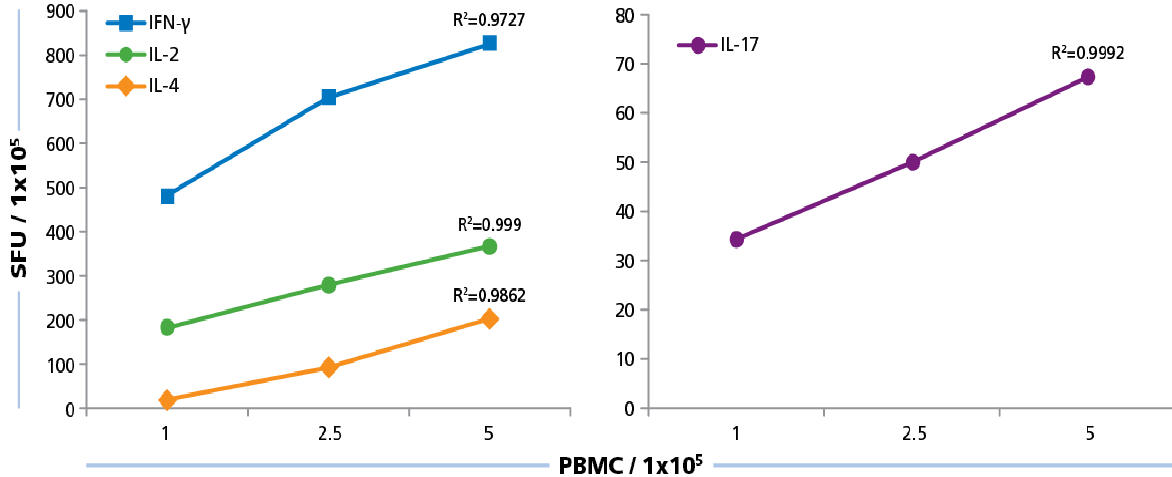
Figure 5. Cell number dependence of ELISPOT formation. PBMC were plated at 100,000